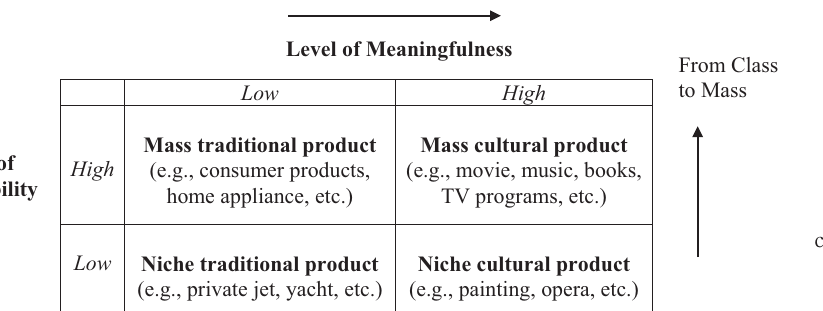
categorization based on meaningfulness and